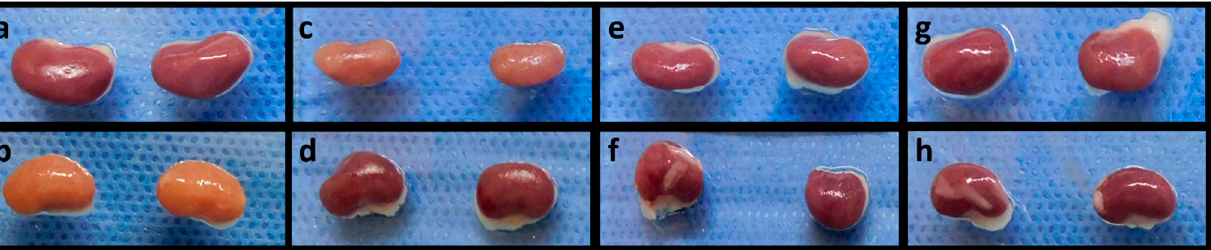
Figure 4. Comparison of kidney damage induced by adenine after 28 days of treatment. Representa- tive photographs of both kidneys were taken. Adenine-intoxicated kidneys show extensive areas of fibrotic tissue ( b ) compared to the control healthy kidneys ( a ). QNPs ( d , f , h ) prevent the damage in the renal parenchyma to a greater extent than QMPs ( c , e , g ). ( a ): Control, ( b ): Ad, ( c ): Ad + QMP25, ( d ): Ad + QNP25, ( e ): Ad + QMP50, ( f ): Ad + QNP50, ( g ): Ad + QMP100, ( h ): Ad +